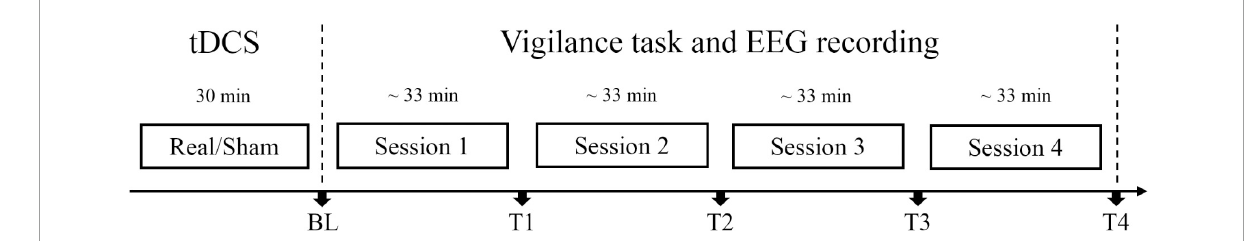
FIGURE1 Experiment protocol. Participants in real tDCS group or sham tDCS group received real tDCS or sham tDCS for 30 min, respectively. Each session lasted for about 33 min. At each time point [BL (baseline), T1, T2, T3, and T4], subjective and objective vigilance parameters were assessed: subjective arousal level via the Stanford Sleepiness Scale, performance, and event-related potentials (ERPs) in Oddball and Go/Nogo tasks. Electroencephalography (EEG) data were collected throughout the vigilance